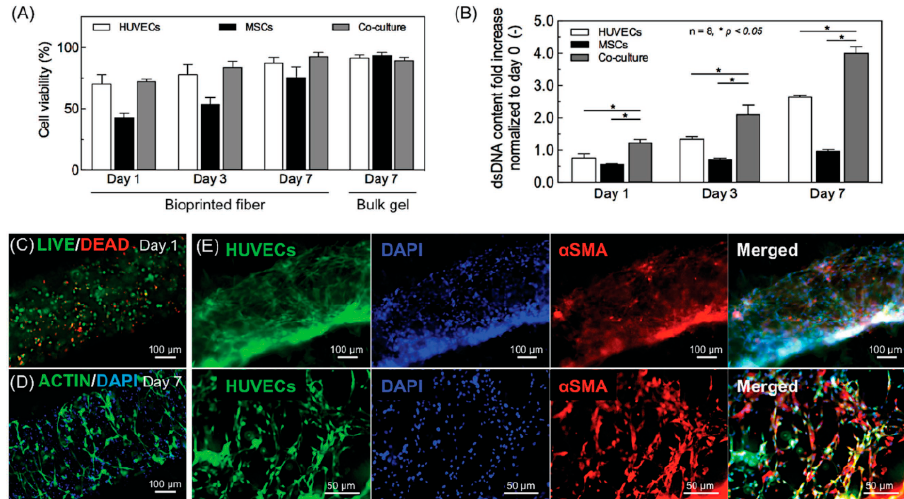
Figure 6. Cell viability and cell proliferation of HUVECs, MSCs and co-culture after one, three, and seven days of culture ( N = 8; * p < 0.05) ( A , B ). Live / Dead staining at Day 1 for cell viability ( C ) and F-Actin / DAPI after seven days of culture for cell spreading ( D ). Co-culture of GFP-HUVECs and MSCs in the bioprinted capillaries after seven days of culture. Differentiation of MSCs into perivascular cells was confirmed by staining of α -SMA. Reprinted from Reference [48], with permission from John Wiley and